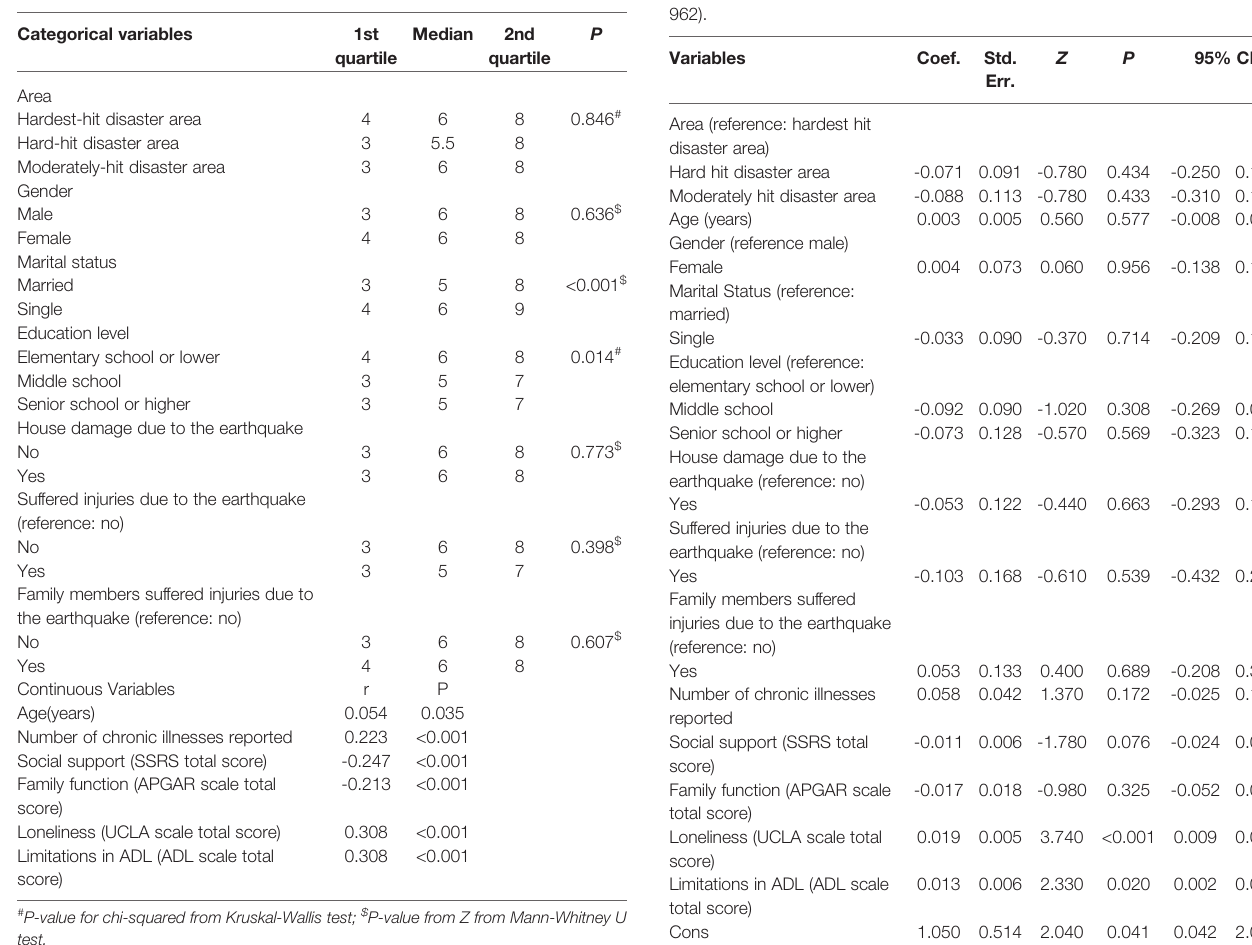
OR, odds ratio; CI, con fi dence interval; SSRS, social support rating scale; APGAR, the adaptation, partnership, growth, affection, and resolve of family members; UCLA, University of California Los Angeles; ADL, activities of daily